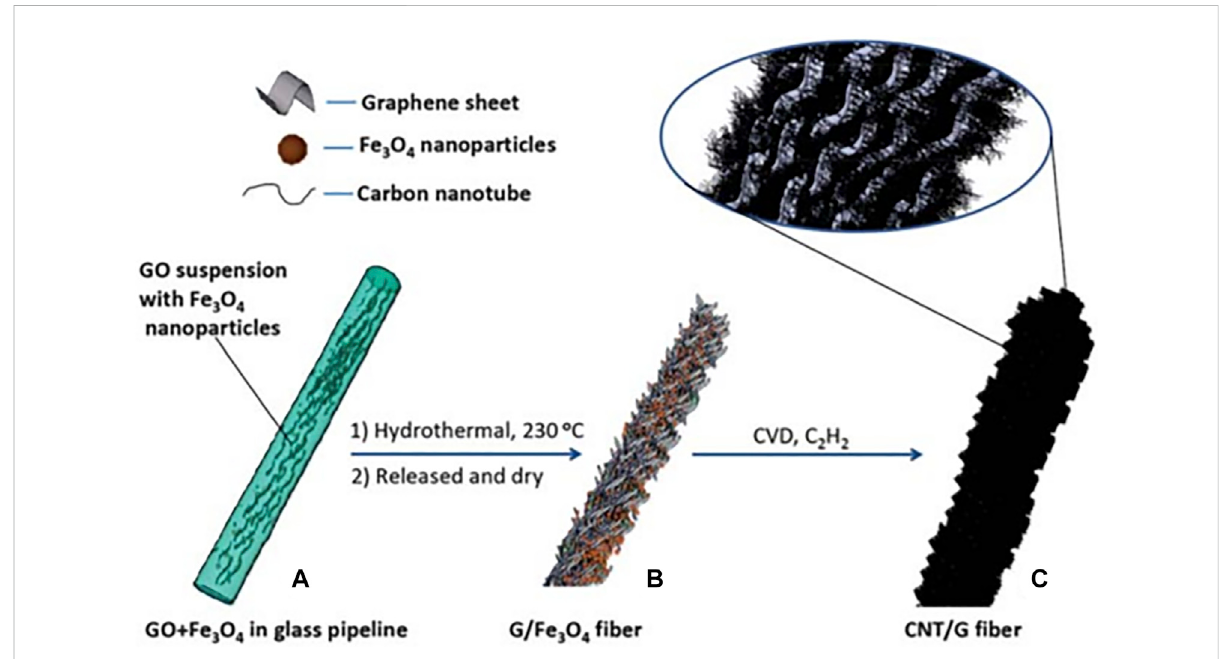
FIGURE 14 Diagram of preparation process: (A) GO+Fe 3 O 4 in glass pipeline; (B) G/Fe 3 O 4 fi ber and (C) CNT/G fi ber (Cheng et al.,